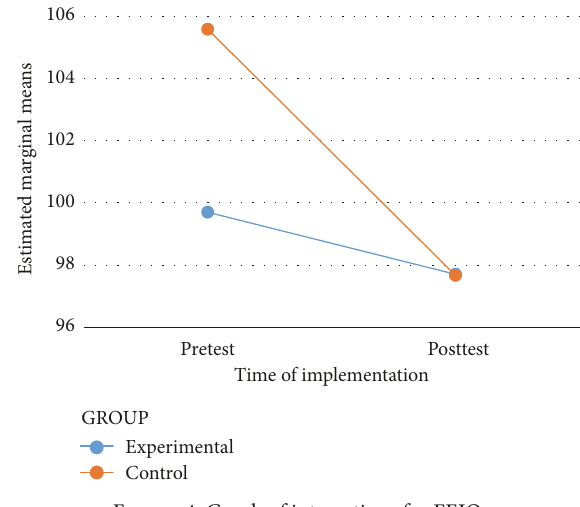
Figure 3: Graph of interactions for PEIQ. Figure 4: Graph of interactions for